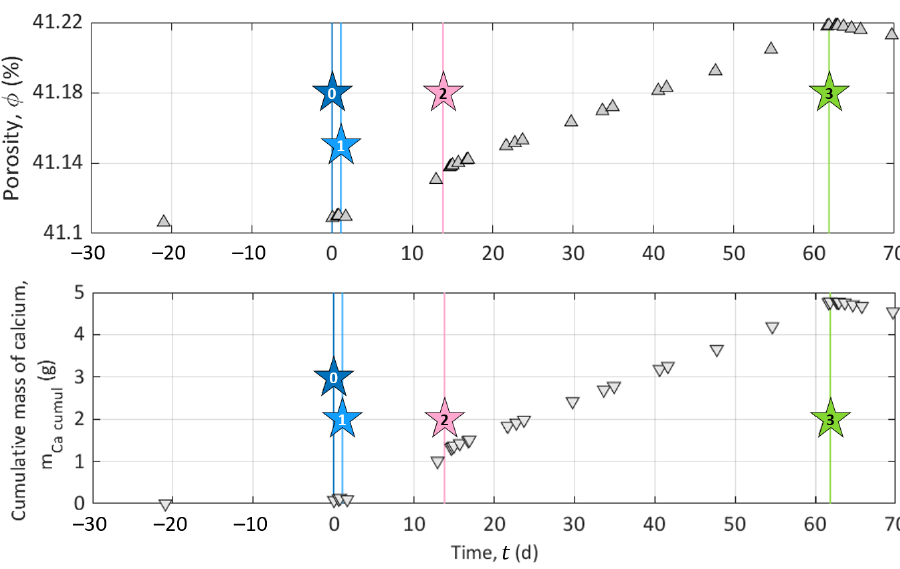
Figure 6. Porosity and cumulative mass of dissolved calcium evolution during the